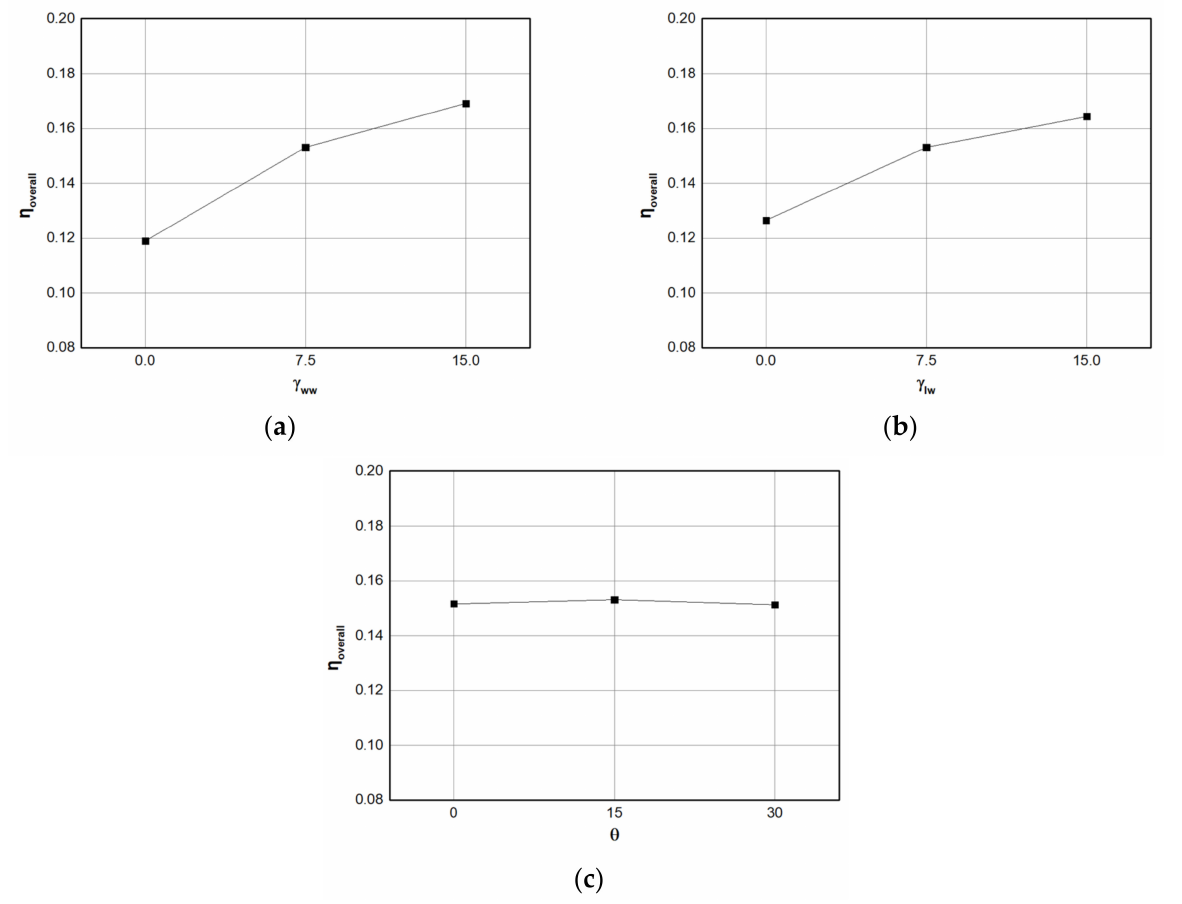
Figure 10. Main effects plots: ( a ) windward lateral expansion angle; ( b ) leeward lateral expansion. angle ( c ) Compound